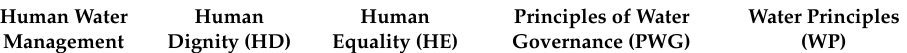
Table 2. Loads ( λ ) of the item with the construct.